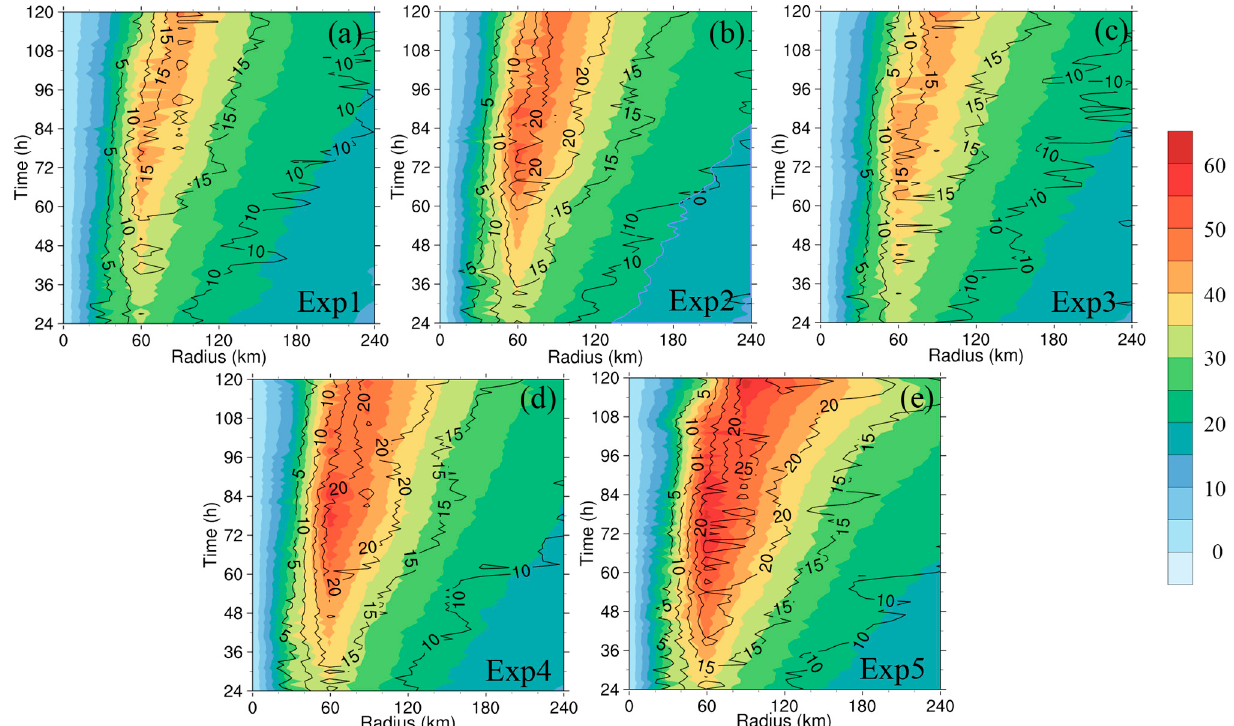
Figure 13. Hovmöller diagrams of the azimuthally averaged winds (expressed by colors) and radial winds (expressed by lines) simulated by the five experiments ( a – e ). The abscissa is the radial distance from the center of the TC, and the ordinate is the simulation time.